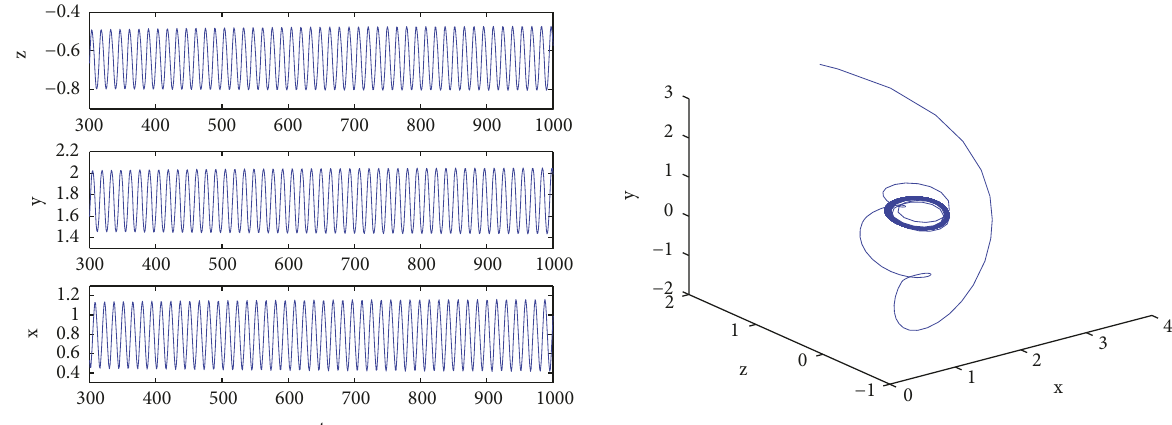
Figure 5: E ∗ + is unstable, and a stable periodic solution appears with 𝜏 1 = 2.77 and 𝜏 2 = 0